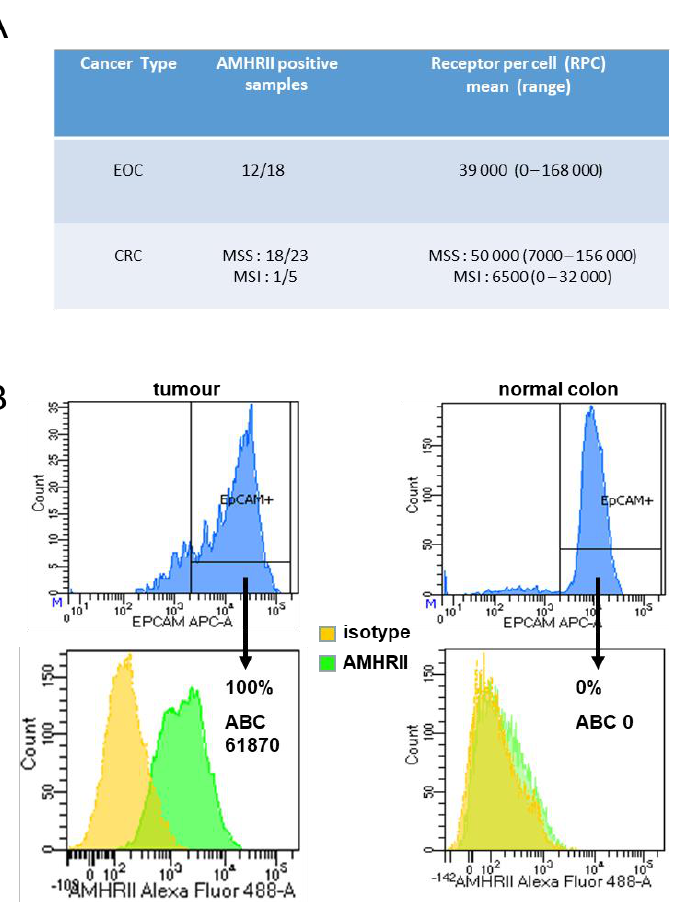
Figure 4. AMHRII expression by flow cytometry in ovarian and colorectal cancers. ( A ) The number of RPC was assessed as mentioned in the Material and Methods section. ( B ) representative images of AMHRII expression in EpCam+ cells in a MSS CRC and in its paired normal colonic mucosa.